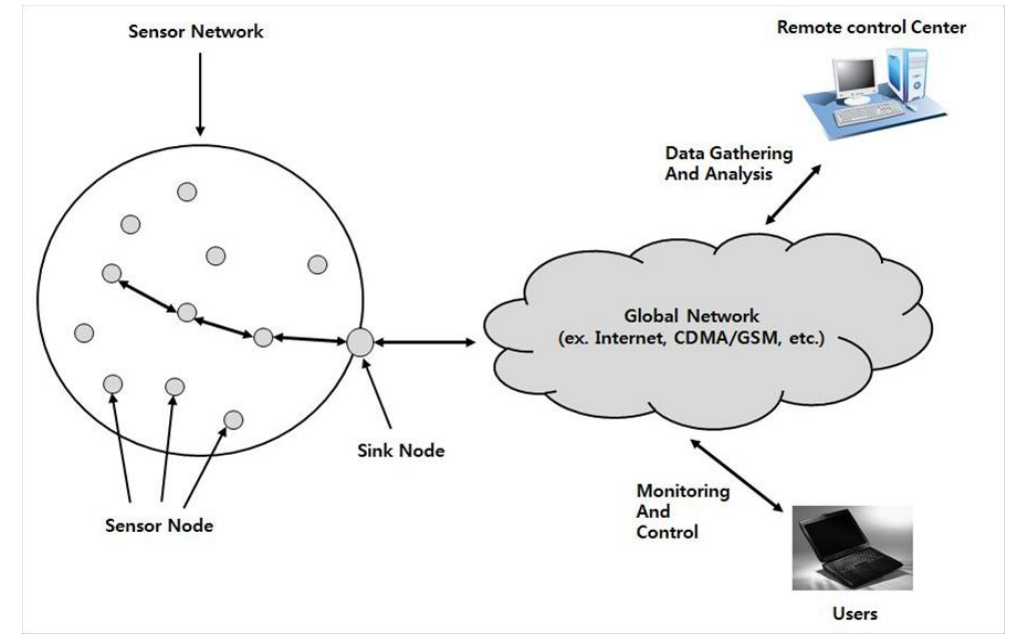
Figure 4. Basic system structure using USN